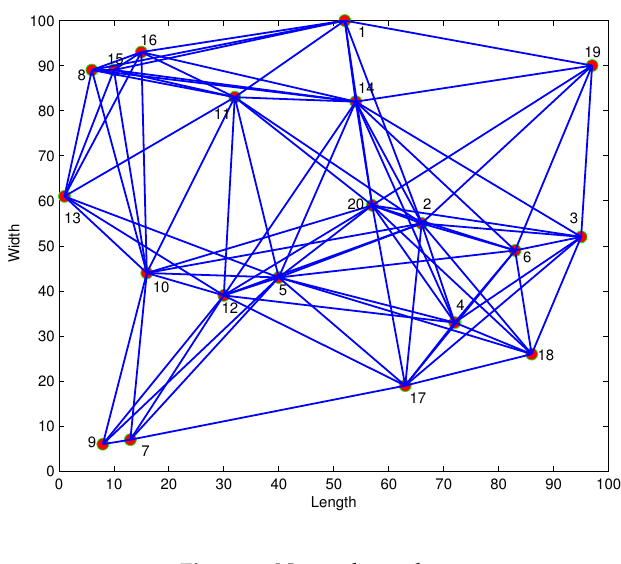
Figure 1. Network